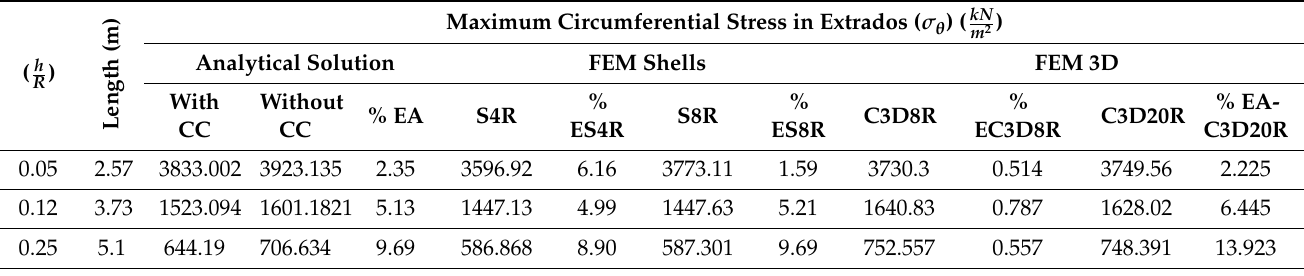
Figure 13. Circumferential flexural moment for thin, medium and thick shells, considering different models. Table 5. Maximum circumferential stress in extrados for different slenderness ratio.